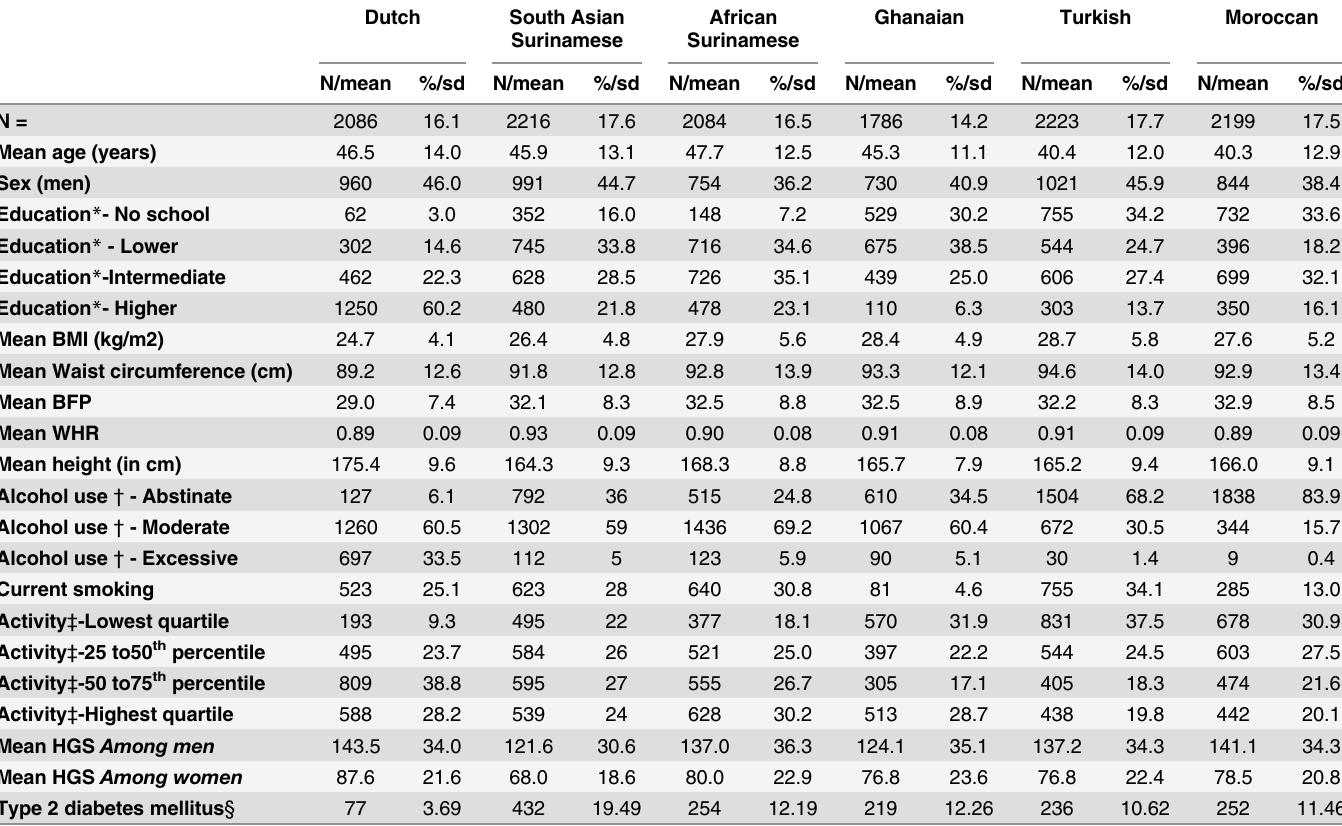
Table 1. Characteristics of the study